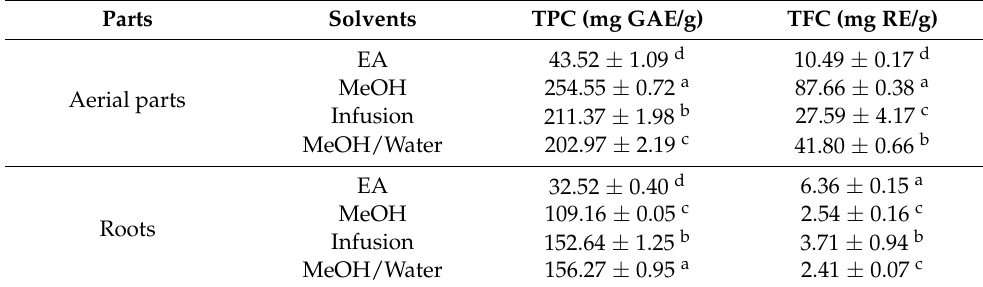
Table 1. Total phenolic and flavonoid content of Epilobium hirsutum